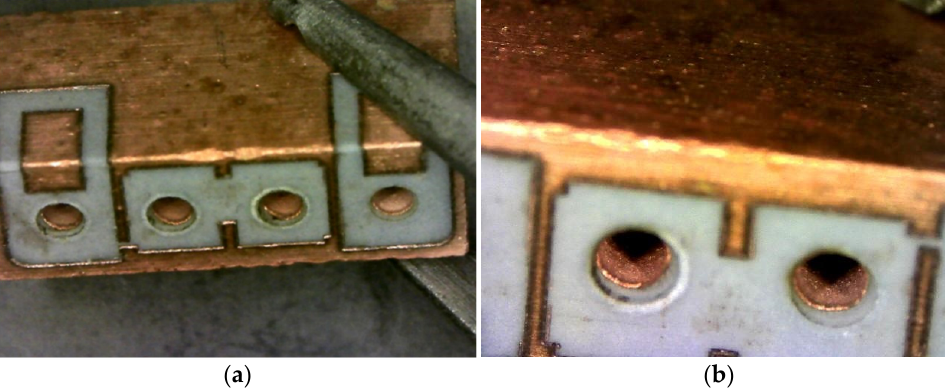
Figure 17. The manufactured microwave dielectric ceramic filter: ( a ) The laser trimming the opening